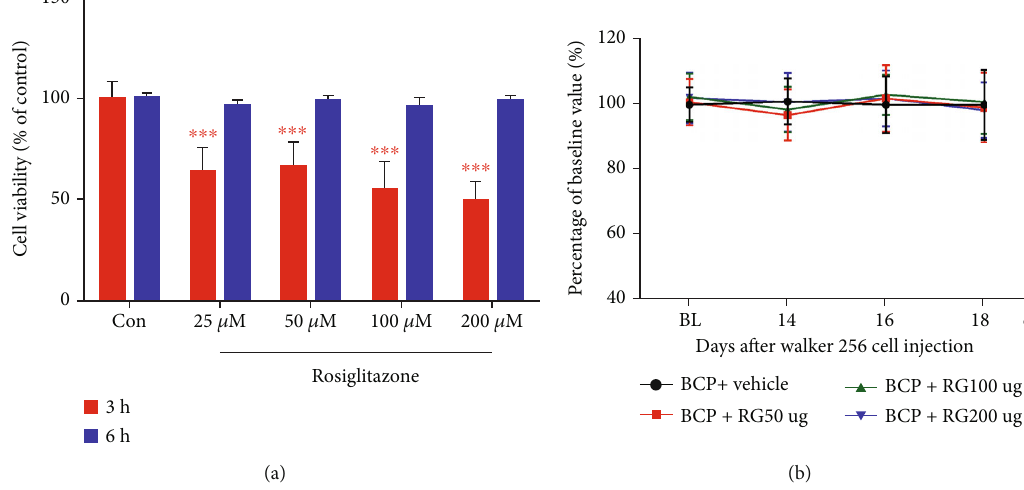
Figure 2: E ff ect of rosiglitazone on the growth of tumor cells and the e ff ect of repeated intrathecal administration of rosiglitazone determined through the rotarod test. (a) Compared with the control group, rosiglitazone signi fi cantly inhibited the viability of Walker 256 cells at 3 h ( ∗∗∗ p < 0 : 001 vs. controls; two-way repeated measures ANOVA (a)), with no signi fi cant di ff erence at 6 h ( p > 0 : 05 vs. controls; two-way repeated measures ANOVA (a)). (b) Compared with vehicle treatment bone cancer pain (BCP) group, intrathecal injection of rosiglitazone (50, 100, and 200 μ g) for 5 days did not a ff ect the motor performance of rats with BCP ( p > 0 : 05 vs. vehicle control group; two-way repeated measures ANOVA (b)). The results are expressed as the percentage of each rat ’ s baseline value. BL: baseline; Con: control; RG: